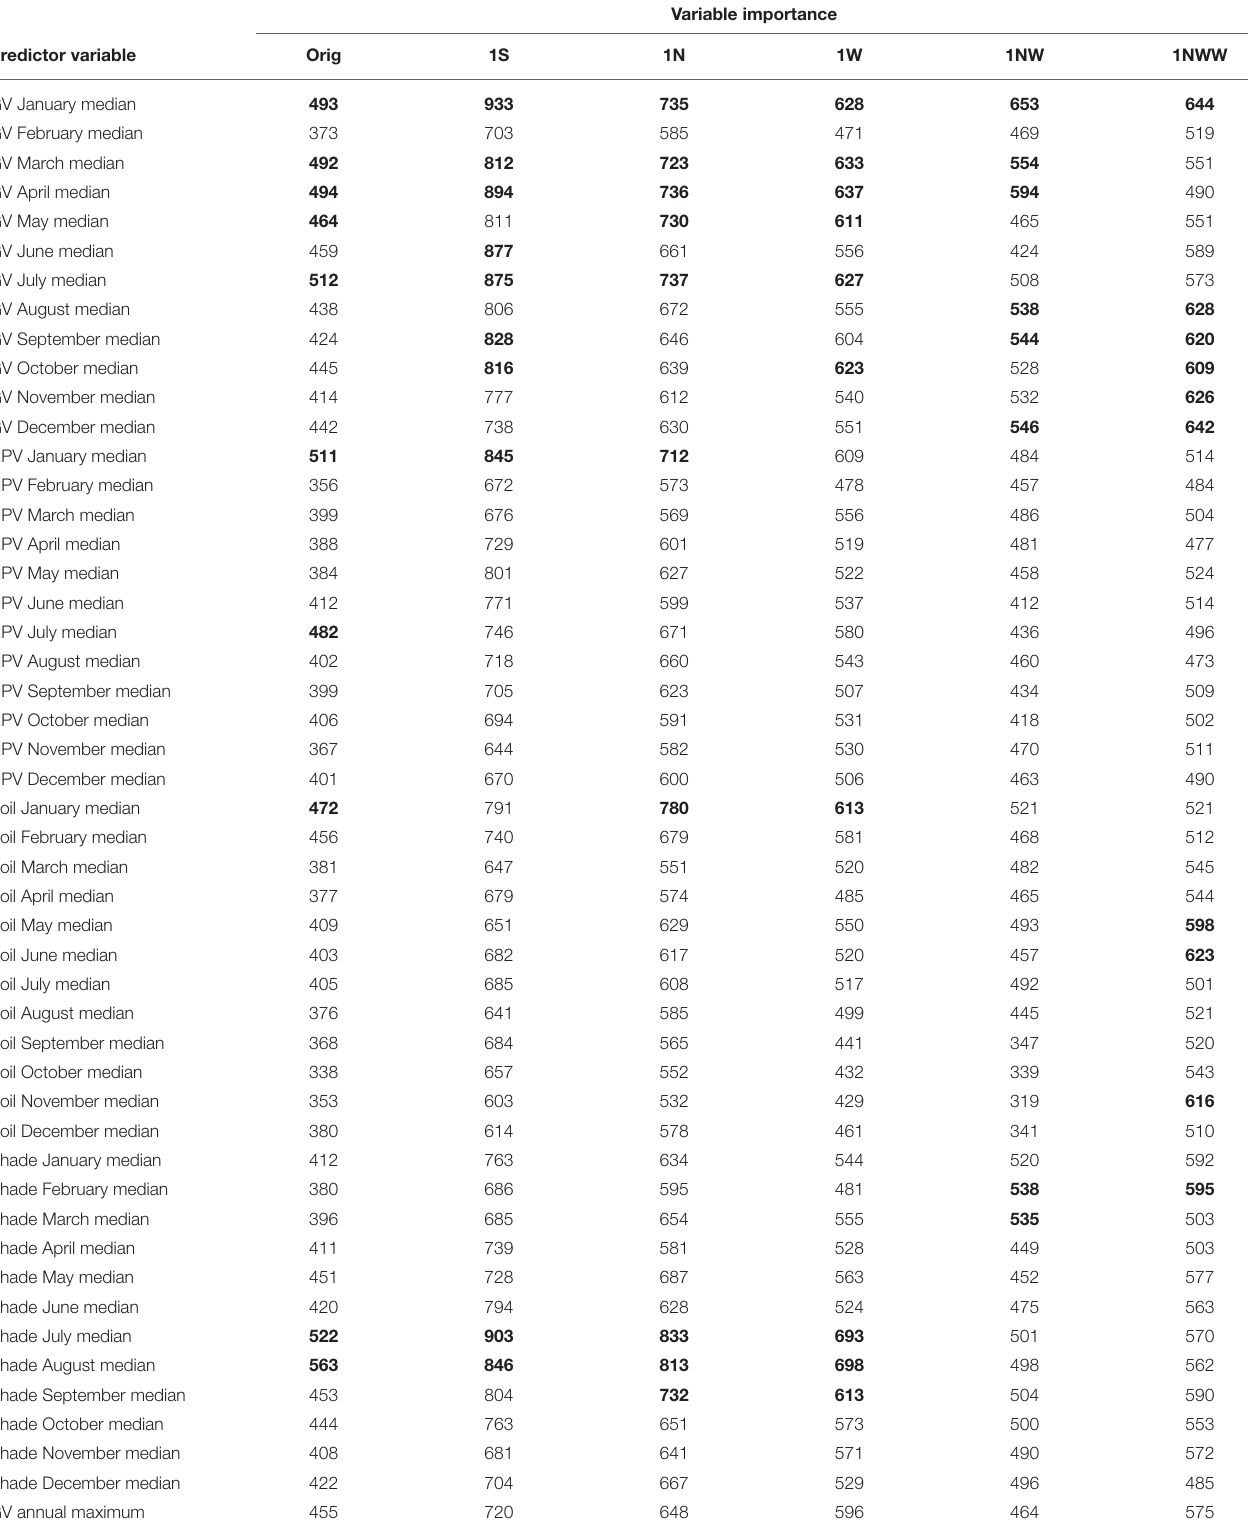
TABLE 5 | Random Forest variable importance measures for the six primary tiles, the geographical location of the tiles is shown in Figure 2